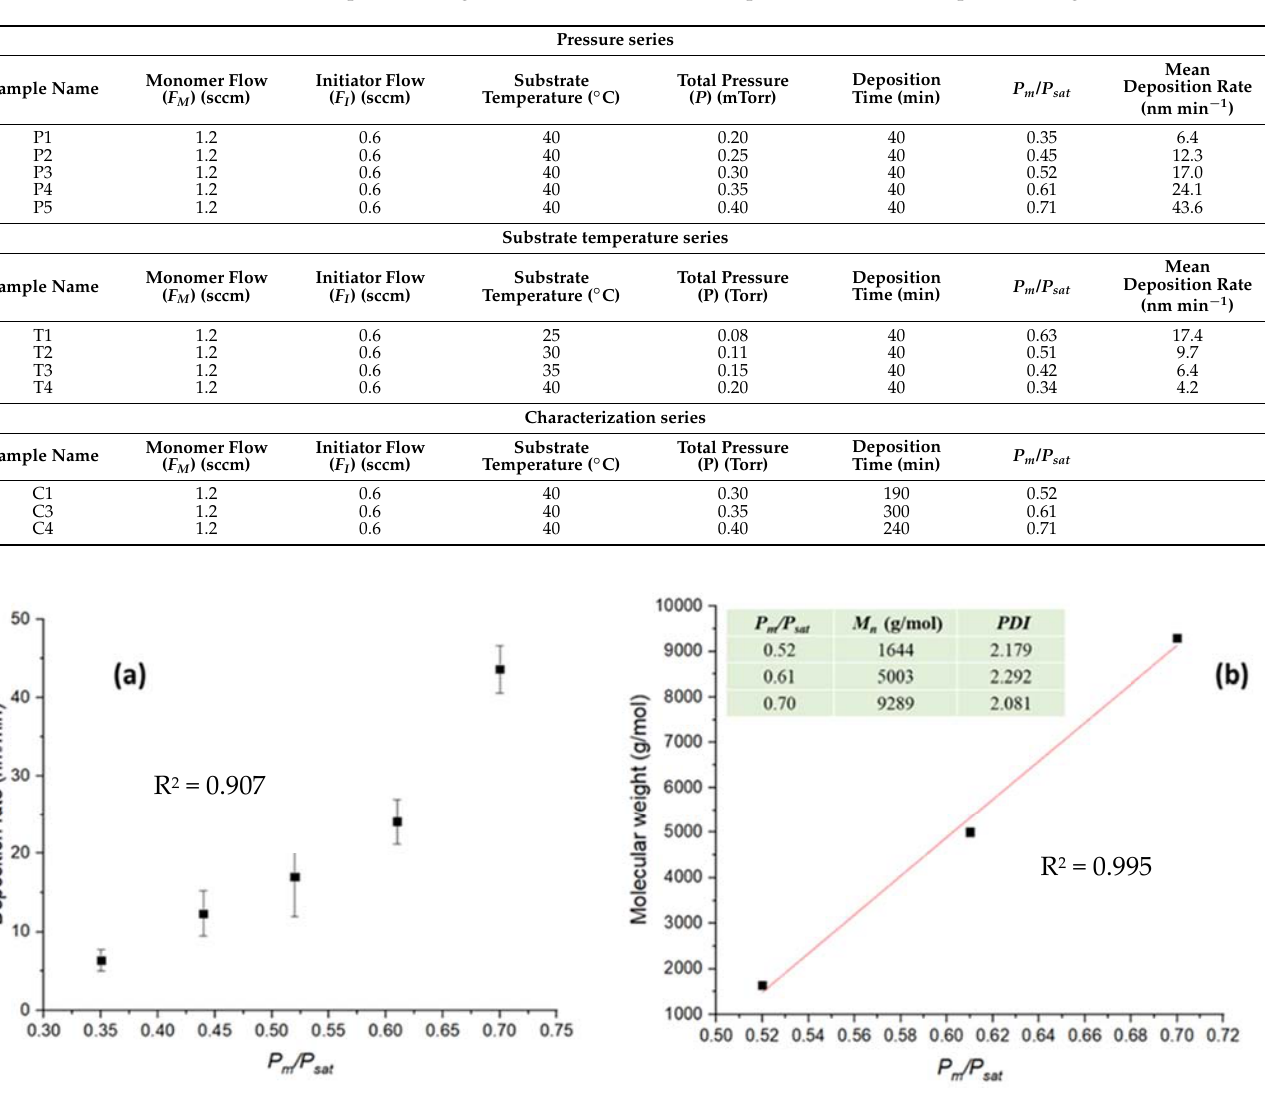
Figure 2. ( a ) PMBL deposition rate as a function of P m / P sat and ( b ) P m / P sat versus number ‐ average molar mass ( M n ).